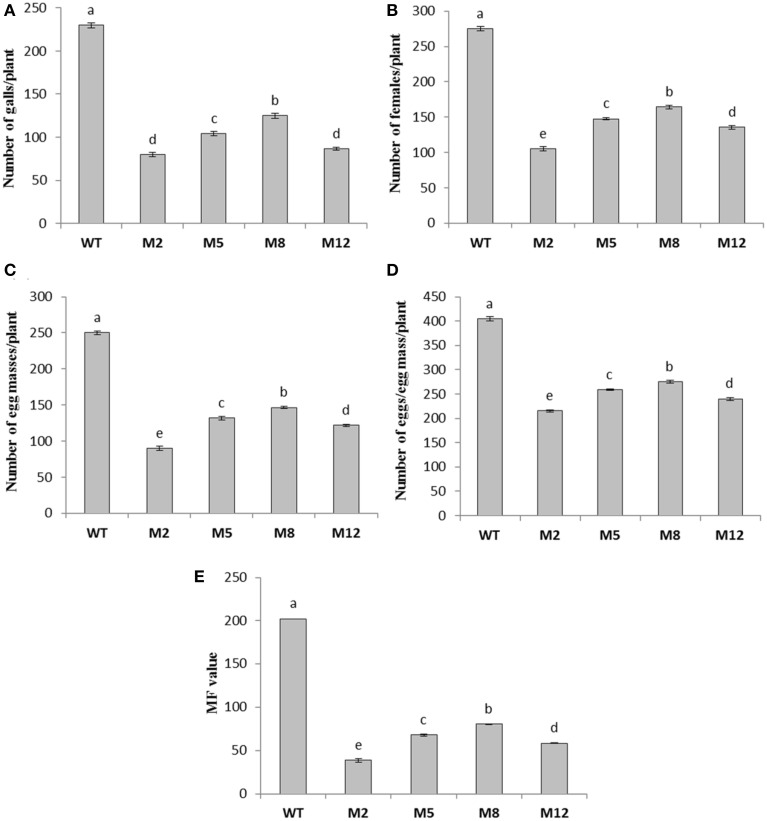
Effect of host induced gene silencing of Mi-cpl-1 on development and reproduction of M. incognita. Relative number of galls (A), females (B), egg masses (C), eggs/egg mass (D) and the respective multiplication factor (MF) of M. incognita
(E) in different transgenic events (M2, M5, M8, and M12) and wild type plants (WT) at 35 DPI. Each bar represents the mean ±SE of n = 4, and bars with different letters denote a significant difference at P < 0.05, CRD test.